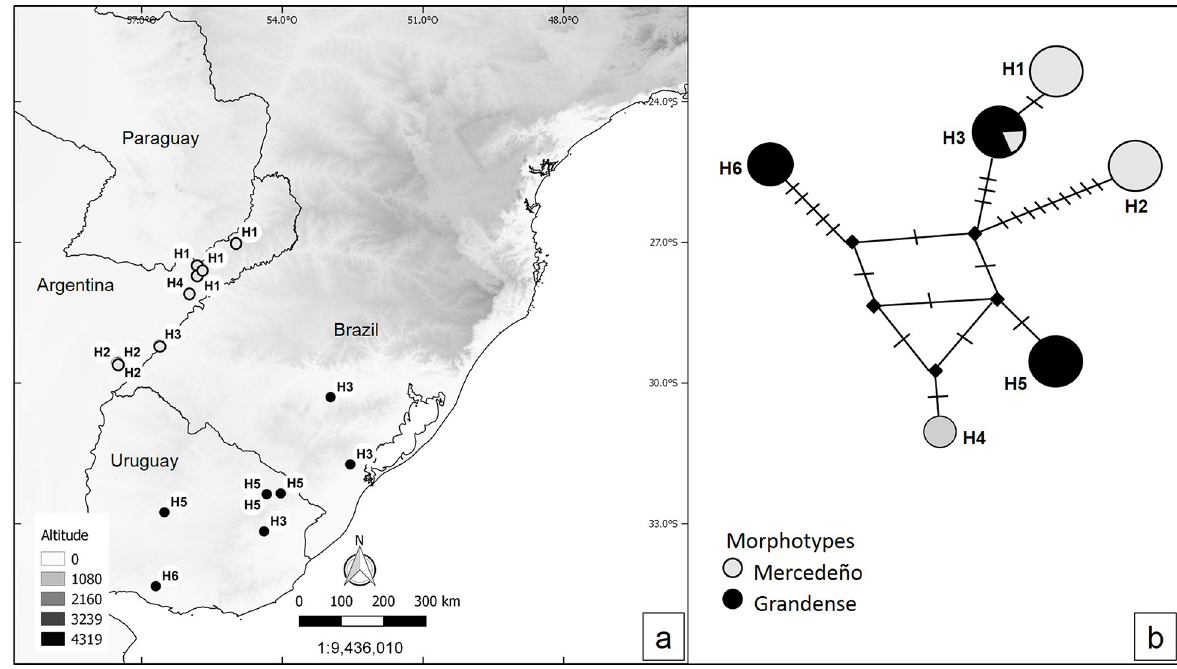
Figure 8. Geographic distribution of cpDNA haplotypes (a) and evolutionary relationships among cpDNA haplotypes using a median-joining network approach (b) of the 17 populations studied of Turnera sidoides subsp. carnea . Circle sizes in the network are proportional to the haplotype frequency, crossed lines are substitutions inferred in the branches and diamonds are median vectors placed by the